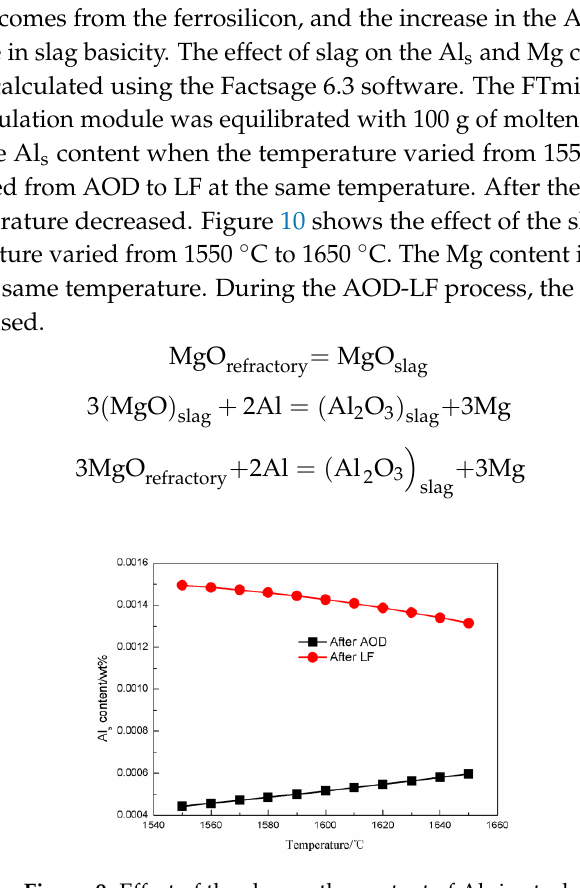
Figure 8. Chemical composition of inclusions in the tundish.